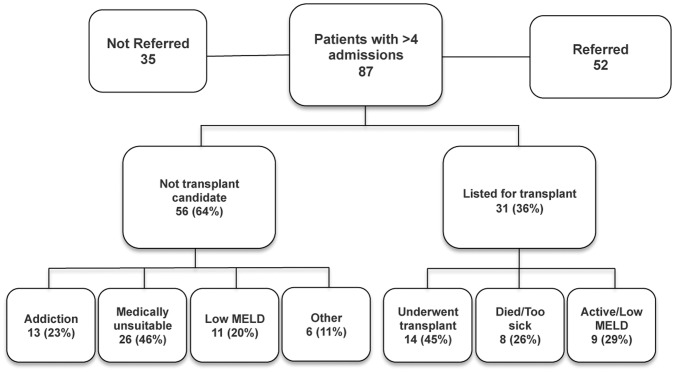
Flowchart showing transplant-related outcomes in patients with >4 admissions.Patients deemed to not to be transplant candidates include both referred and non-referred patients. Low MELD score patients had MELD <15.